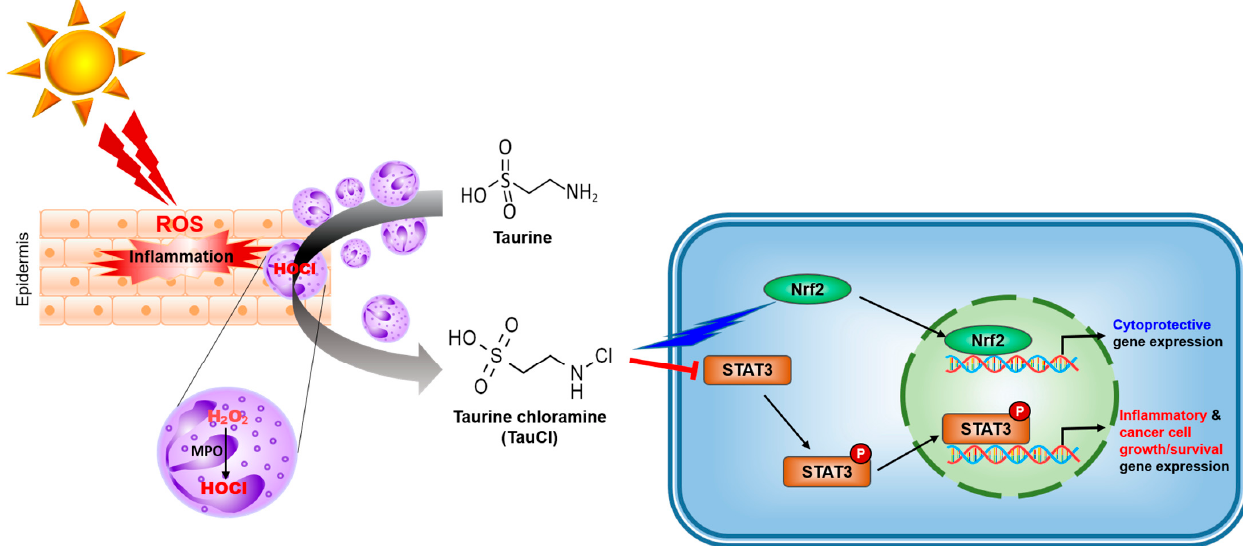
Figure 7. A proposed molecular mechanism underlying the protective effects of TauCl against UVB-induced dermatitis. Exposure to UVB causes inflammatory injury to the skin. Activated neutrophiles recruited to the inflamed site generate ROS, such as hydrogen peroxide, with concomitant release of myeloperoxidase (MPO). MPO catalyzes the reaction of hydrogen peroxide and chloride ion to produce hypochlorous acid (HOCl). HOCl is a strong oxidant and is neutralized by reacting with taurine, which produces TauCl. TauCl exerts antioxidant and anti-inflammatory effects by activating Nrf2 and blocking STAT3 signaling, leading to protection against UVB-induced skin damage.